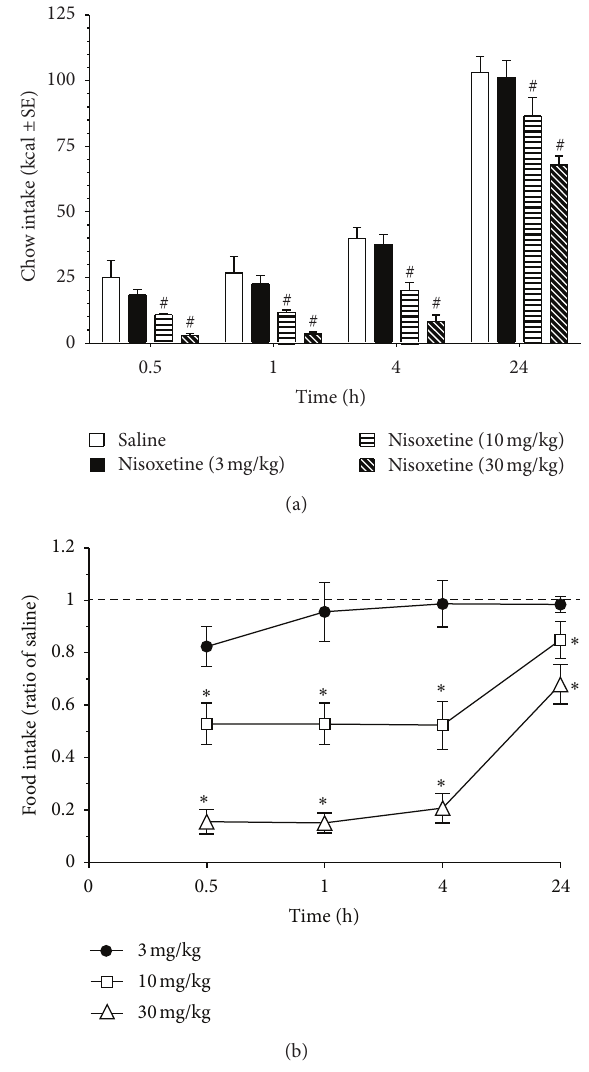
F 1: Dose response of acute nisoxetine or saline on the re- feeding intake of standard chow. Animals underwent a 24h food deprivation prior to injections and refeeding. All animals were fed and maintained on standard chow (13 fat, 27 protein). Doses were randomly administered with a week washout between doses. (a) Intake (Kcal) shown is cumulative. # indicates differences ( % % ) from all other doses. (b) Data expressed as ratio of food intake following saline at the individual time points. Dotted line 𝑃𝑃 𝑃 represents intake from saline injected animals (ratio of 1.0) to 𝛼𝛼𝛼𝛼 illustrate the feeding suppression of nisoxetine. Asterisks indicate signi�cant differences ( ) from 3mg/kg dose at respective time 𝑃𝑃 𝑃 𝛼𝛼𝛼𝛼